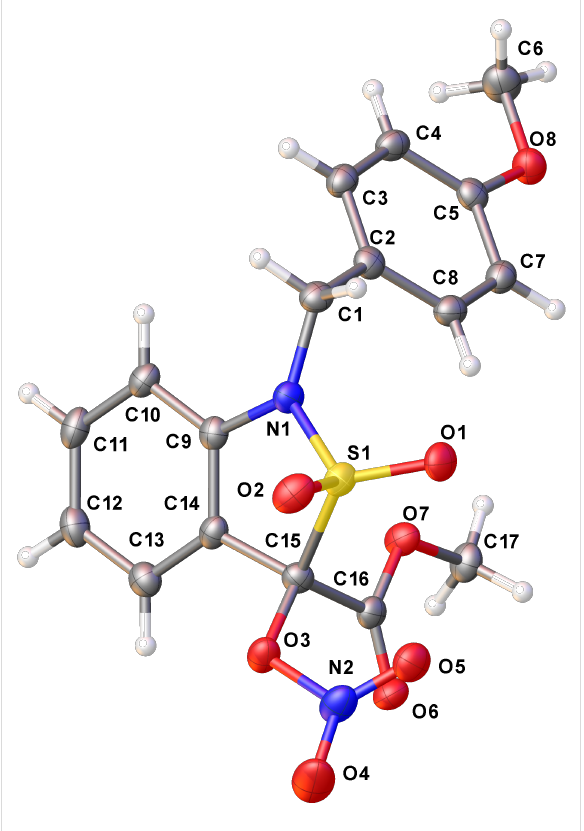
Figure 2: Structure of methyl 1-(4-methoxybenzyl)-3-(nitrooxy)-1,3- dihydrobenzo[c]isothiazole-3-carboxylate-2,2-dioxide ( 22 ) in the